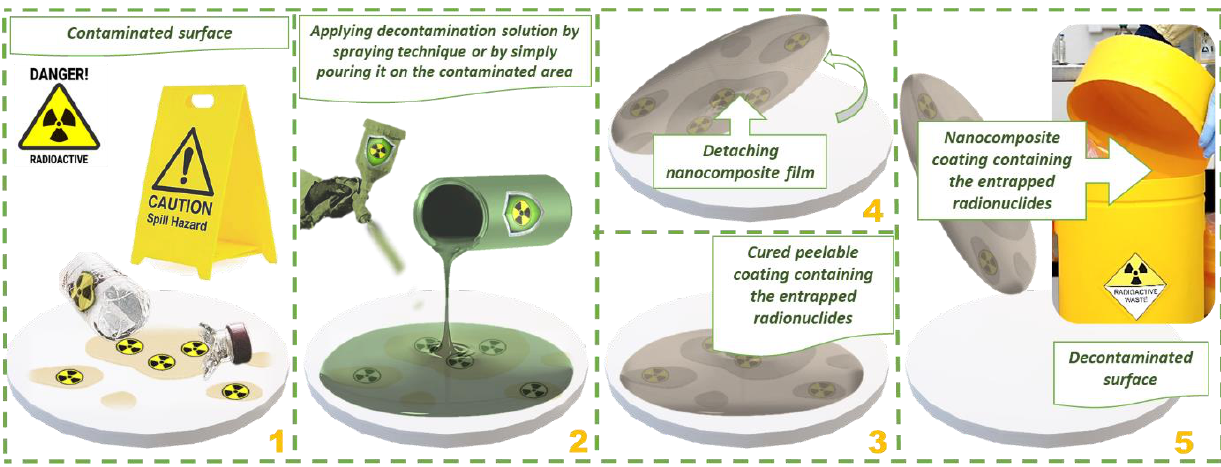
Figure 5. Radionuclide accidental spilling: decontamination scenario employing the nanocomposite strippable coatings. ( 1 ) Securing the contaminated area; ( 2 ) Applying the decontaminating formulation; ( 3 ) Entrapping the contaminants inside the polymer-clay system and allowing the curing of the nanocomposite film; ( 4 ) Peeling the film containing the entrapped radionuclides; ( 5 ) Safe disposal with minimal amount of waste.